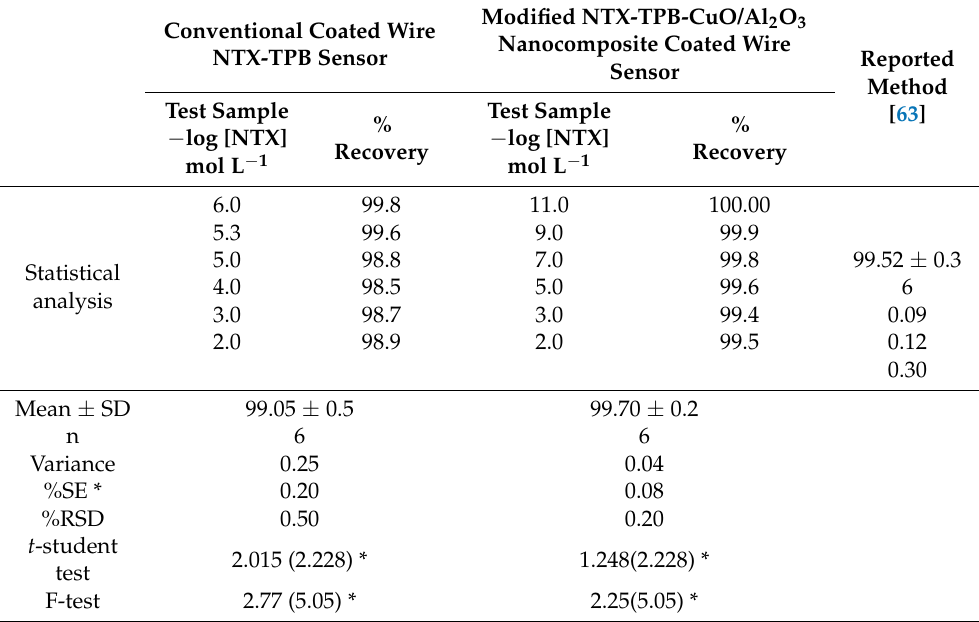
Table 6. The calculated resulted from the quantification of NTX in Naltrexone hydrochloride ® 50 mg/tablet using the designed conventional coated wire NTX-TPB and modified NTX-TPB- CuO/Al 2 O 3 nanocomposite sensors.